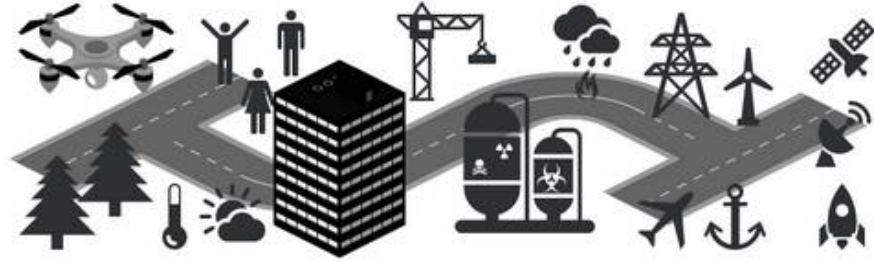
Figure 1. Application of UAVs and selected threads for consideration.